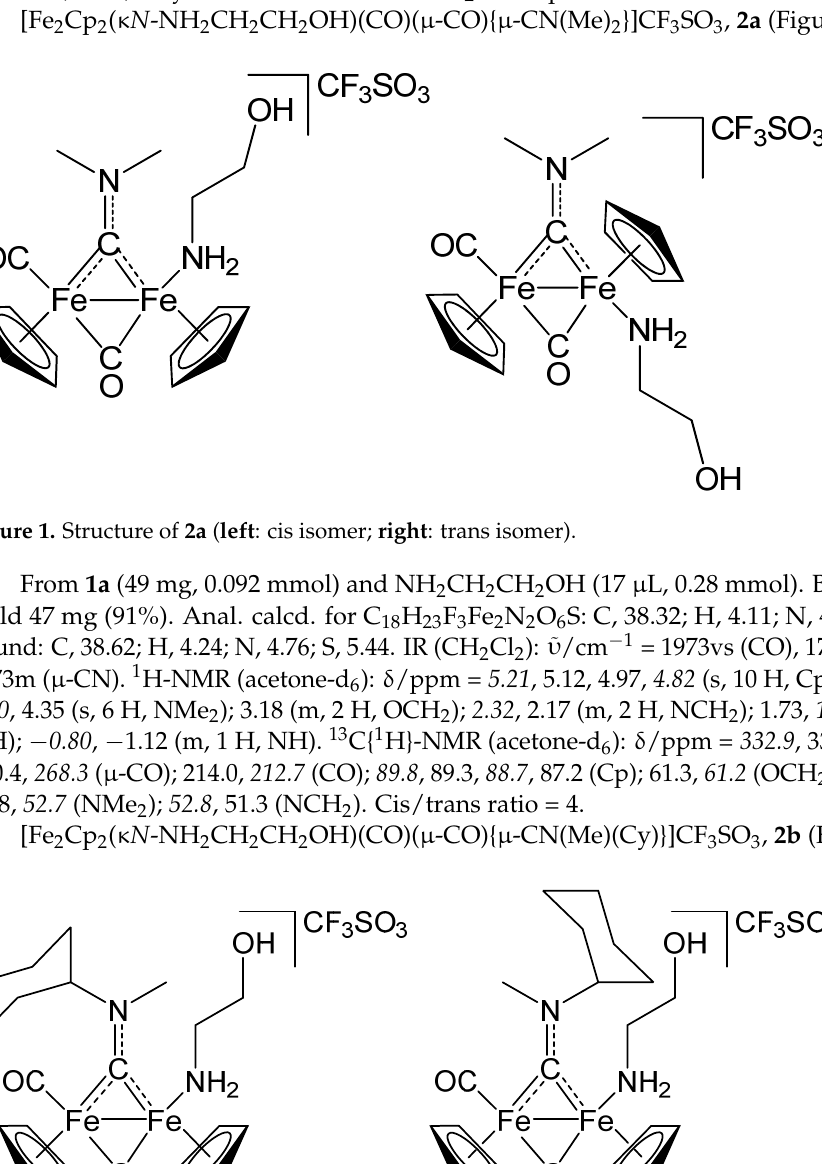
Figure 2. Structure of 2b ( left : α isomer; right : β isomer). From 1b (130 mg, 0.217 mmol) and NH 2 CH 2 CH 2 OH (65 μ L, 1.1 mmol). Brown solid, yield 129 mg (95%). Anal. calcd. for C 23 H 31 F 3 Fe 2 N 2 O 6 S: C, 43.69; H, 4.94; N, 4.43; S, 5.07. Found: C, 43.46; H, 5.03; N, 4.36; S, 5.14. IR (CH 2 Cl 2 ): ῦ /cm − 1 = 1970vs (CO), 1799s ( μ -CO), 1532w ( μ -CN). 1 H NMR (CDCl 3 ): δ /ppm = 5.66 , 4.80* (m, 1 H, CH Cy ); 4.85 , 4.83, 4.80 , 4.79 (s, 10 H, Cp); 4.50, 4.09 (s, 3 H, NMe); 3.60, 3.39–3.32 (m, 2 H, OCH 2 ); 3.20–3.13, 2.84 (m, 2 H, NCH 2 ); 2.43–2.35 (m, 1 H, NH); 2.31–2.28, 2.20–2.11, 1.57–1.45, 1.41, 1.29 (m, 10 H, CH 2Cy ); − 1.92 , − 2.14 (m, 1 H, NH). * Overlapped with Cp resonance. 13 C{ 1 H} NMR (CDCl 3 ): δ /ppm = 331.1 , 330.5 ( μ -CN); 268.5 , 268.1 ( μ -CO); 212.6, 212.4 (CO); 120.5 (q, 1 J CF = 320 Hz, CF 3 ); 88.1 , 87.9, 86.7, 86.6 (Cp); 78.4, 75.3 (CH Cy ); 61.0 , 60.8 (OCH 2 ); 50.7, 49.7 (NCH 2 ); 46.4 , 45.1 (NMe); 33.0, 32.6, 31.8, 31.6, 31.1, 31, 30.8, 26.1, 26, 25.5, 25.3, 25.1, 24.5 (CH 2Cy ). α / β ratio = 2. [Fe 2 Cp 2 ( κ N -NH 2 CH 2 CH 2 OMe)(CO)( μ -CO){ μ -CN(Me)(Cy)}]CF 3 SO 3 , 2c (Figure 3)